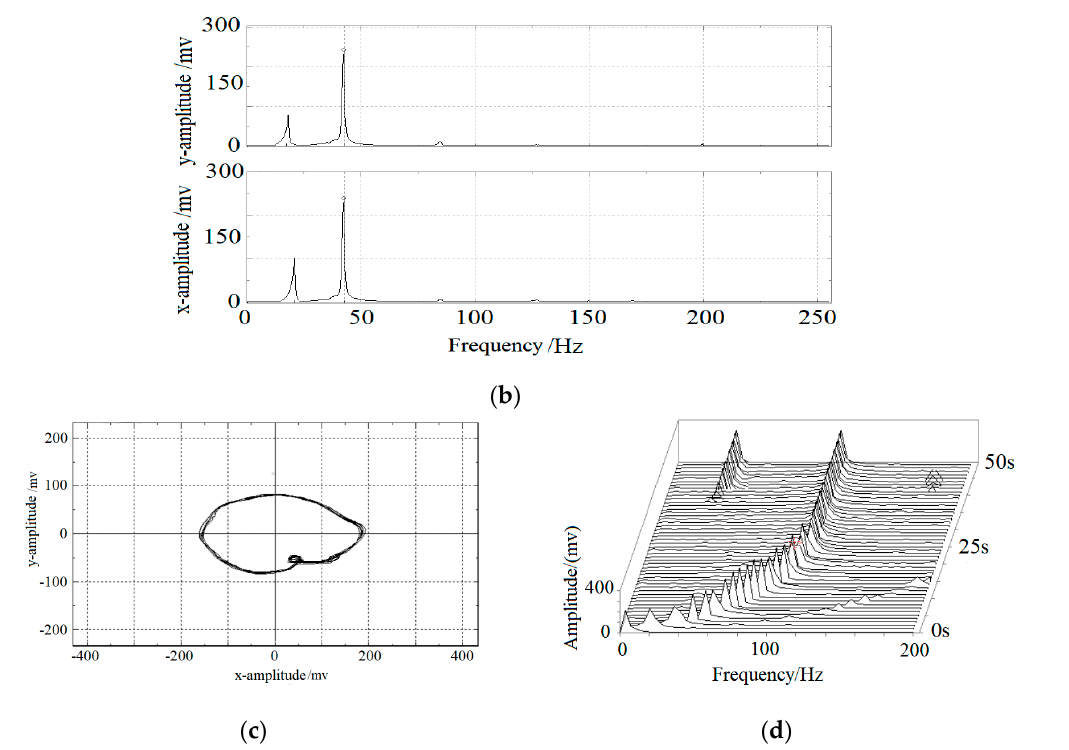
Figure 12. Dynamic response of the floating ring system (test result), when λ = 0.01 and speed ratio is S = 1.58: ( a ) time-domain waveform; ( b ) the FFT spectrum of rotor; ( c ) axis trajectory; ( d ) waterfall diagram .